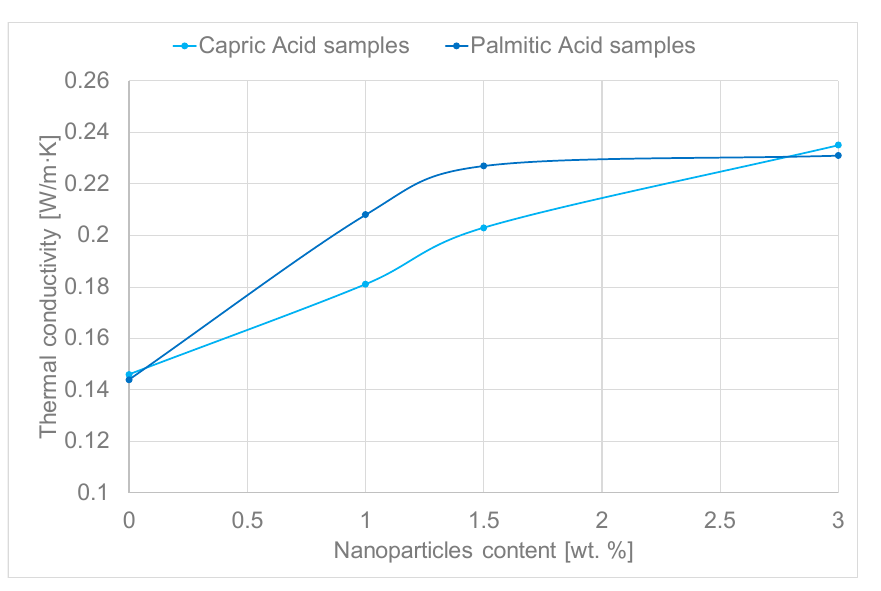
Figure 6. Effective thermal conductivity results vs. nanoparticles content.